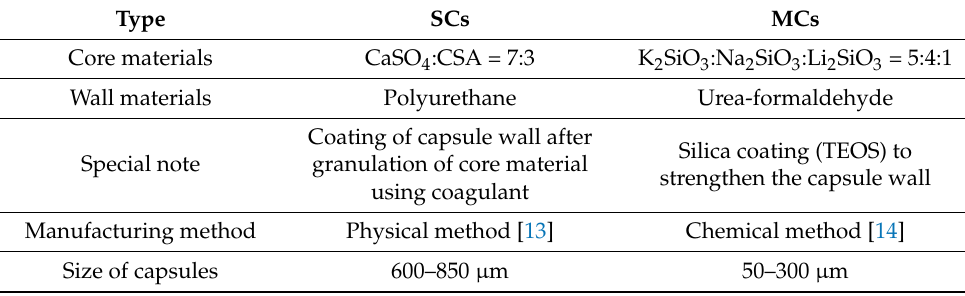
Figure 3. Reaction mechanism of the complex capsule. Table 1. Characteristics and manufacturing method of each